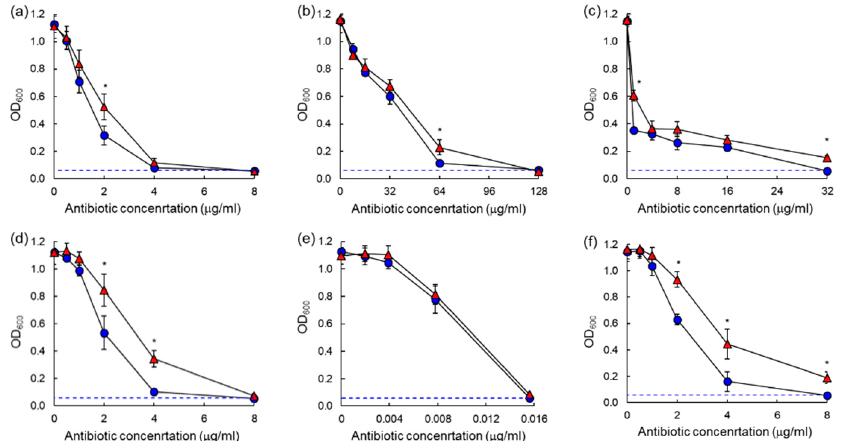
Figure 3. Dose–response curves of antibiotic-resistant Salmonella Typhimurium ATCC 19585 (ASST) exposed to different concentrations of chloramphenicol ( a ), erythromycin ( b ), tetracycline ( c ), cephalothin ( d ), ciprofloxacin ( e ), tobramycin ( f ) after 20 h ( ● ) and 40 h ( ▲ ) of incubation. * indicates the significant difference within MIC at p < 0.05.